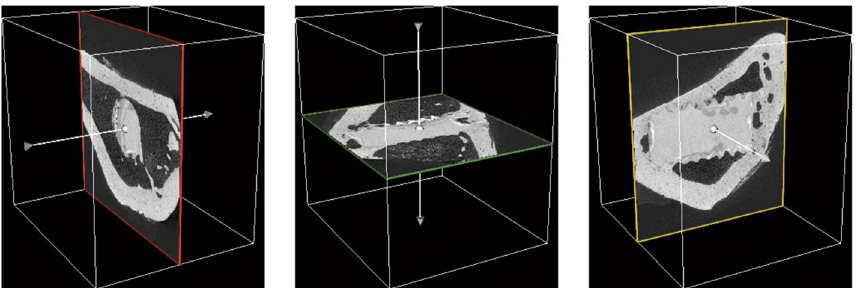
Figure 2. Slicing example (sample 1) for three naive planes (created with 3D Slicer, v4.11, https:// www. slicer. org/). From left to right: S rc is show in red, S cp in green, and S pr in yellow. The arrow indicates the slicing